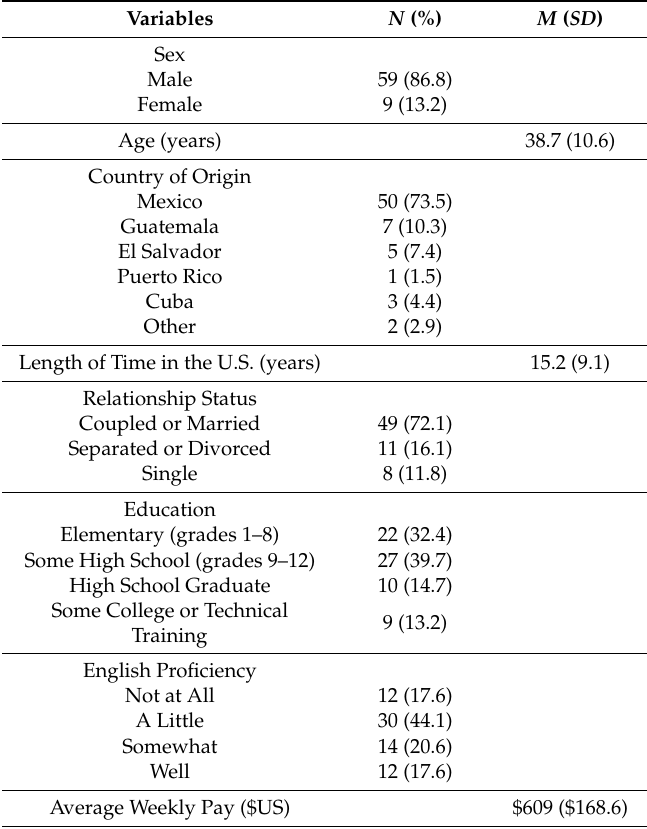
Table 1. Demographic characteristics of